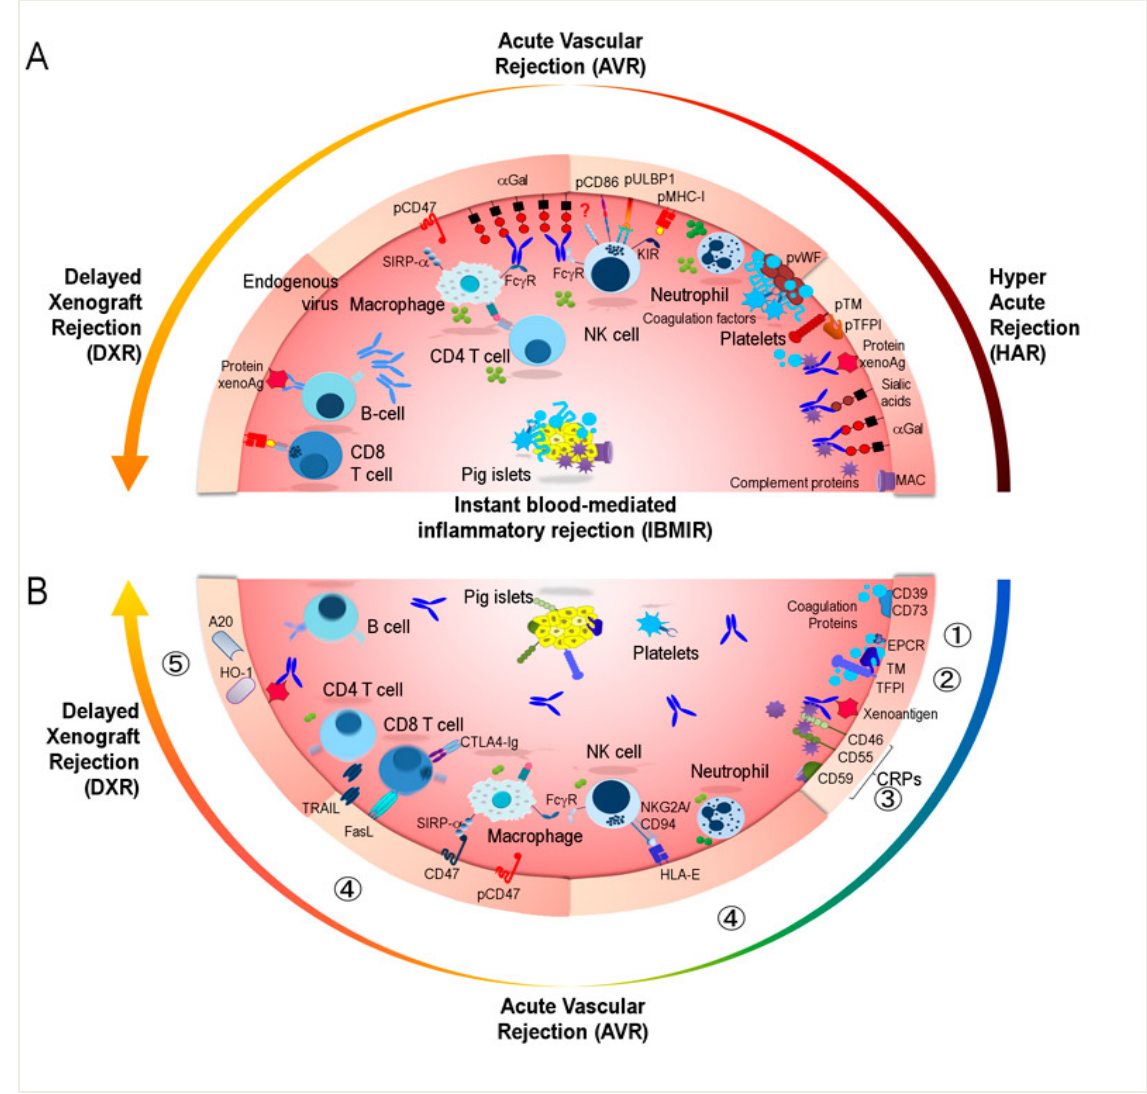
Figure 1: Immunological and coagulation hurdles in pig-to-human xenograft rejection and genetic modifications to overcome them. (A) Hyperacute rejection, within minutes to hours, triggered by the binding of preformed natural antibodies (dark blue) to pig endothelial antigens, mainly αGal but also to sialic acids (Neu5Gc) and pig proteins. Antibody deposition leads to endothelial activation; activation of complement proteins and formation of the membrane attack complex (MAC; both in shown in purple). Activation of the coagulation cascade (in indigo blue) due to species incompatibilities with pig membrane-bound coagulation-regulatory proteins thrombomodulin (pTM) or tissue factor pathway inhibitor (pTFPI), leads to thrombosis and endothelial damage. Human platelets aggregate following interaction with pig von Willebrand factor (pvWF). Acute vascular rejection, within hours to days, mediated by innate immune cells recruited by activated endothelia and proinflammatory signals. Neutrophils release oxygen-reactive species (dark green circles) and proinflammatory cytokines (light green circles); simultaneously, xenoantibodies bound to endothelia trigger antibody-dependent cell-mediated cytotoxicity by natural killer (NK) cells and macrophages. NK cells are activated by: (i) NKG2D responding to the pig activating ligand UL16 binding protein 1 (pULBP-1); (ii) the natural cyto- toxicity triggering receptor 2 (NKp44) by an unknown pig ligand; (iii) a variant of CD28 to porcine CD86; (iv) lack of the inhibitory signals to killer-cell immuno- globulin-like receptors (KIR) by pig MHC class I due to species incompatibility. Macrophages secrete proinflammatory cytokines (light green circles), phagocy- tosis is triggered by species incompatibility of human signal regulatory protein alpha (SIRP α ) and its inhibitory porcine ligand (pCD47). Delayed xenograft rejection, within weeks to months, activation of the acquired immune response leading to induced anti-pig antibodies (light blue) to annexin A2, CD9, CD46, CD59, MHC, etc. by memory B cells and plasma cells (not shown); cytotoxic CD8 T cells react to pig MHCs and other proteins; and CD4 T cells provide help and secrete cytokines (light green circles). Instant blood mediated inflammatory reaction occurs in response to cellular xenografts (islets), induces activation of complement, and the extrinsic pathway of the coagulation system, platelet aggregation. Leucocyte recruitment leads to thrombus formation and islet lysis. (B) Strategies to overcome xenograft rejection:  Modification of xenoantigens by either masking or deletion, most importantly αGal in GalT-KO pigs.  Introduction of human coagulation regulatory proteins, CD39 and CD73, to avoid platelet aggregation; thrombomodulin (TM, CD141); and endothelial protein C receptor (EPCR, CD201) to promote the activation of human protein C which degrades clotting factors; tissue factor pathway inhibitor (TFPI). Deletion of pig von Willebrand factor inducing to human platelet aggregation.  Expression of human complement regulatory proteins (CRP), CD46 (MCP) and CD59 to inactivate complement factors, CD55 (DAF) to accelerate complement decay.  Control of cellular responses by induction of apoptosis using FasL (CD178) or TRAIL (CD253) expression; blocking of T cell co-stimulation with CTLA-4-Ig or LEA29Y; expression of HLA-E to inhibit NK cells via the inhibitory NKG2A/CD94 receptor; and human CD47 to regulate macrophages via SIRP α .  Expression of antiapoptotic A20 to protect porcine endothelial cells from TNF-mediated apoptosis or anti-inflammatory HO-1 to degrade free